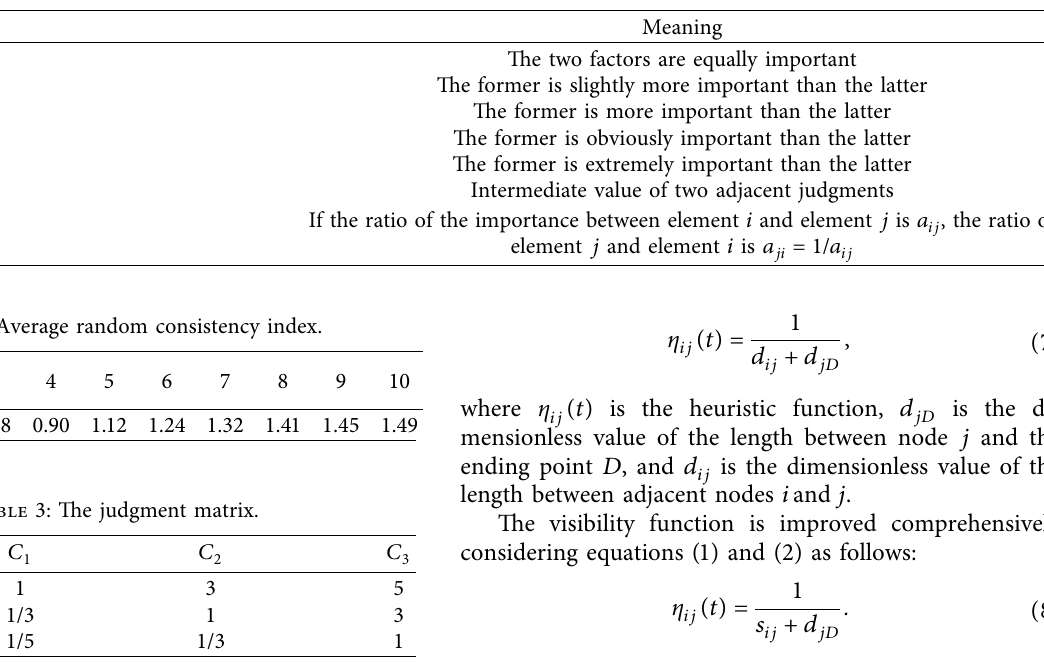
Table 1: Important scale.